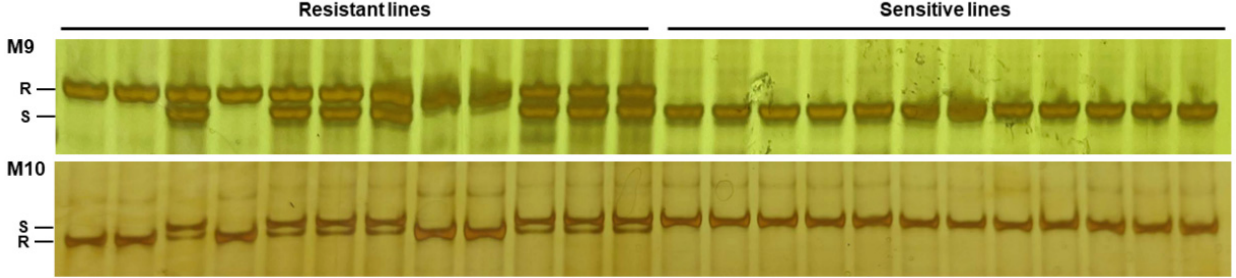
Figure 6. Selection efficiency validation of M9 and M10 for the ZmGHT1 functional allele. A total of 12 resistant and sensitive seedlings were randomly selected, respectively. R: resistant allele; S: sensitive allele.